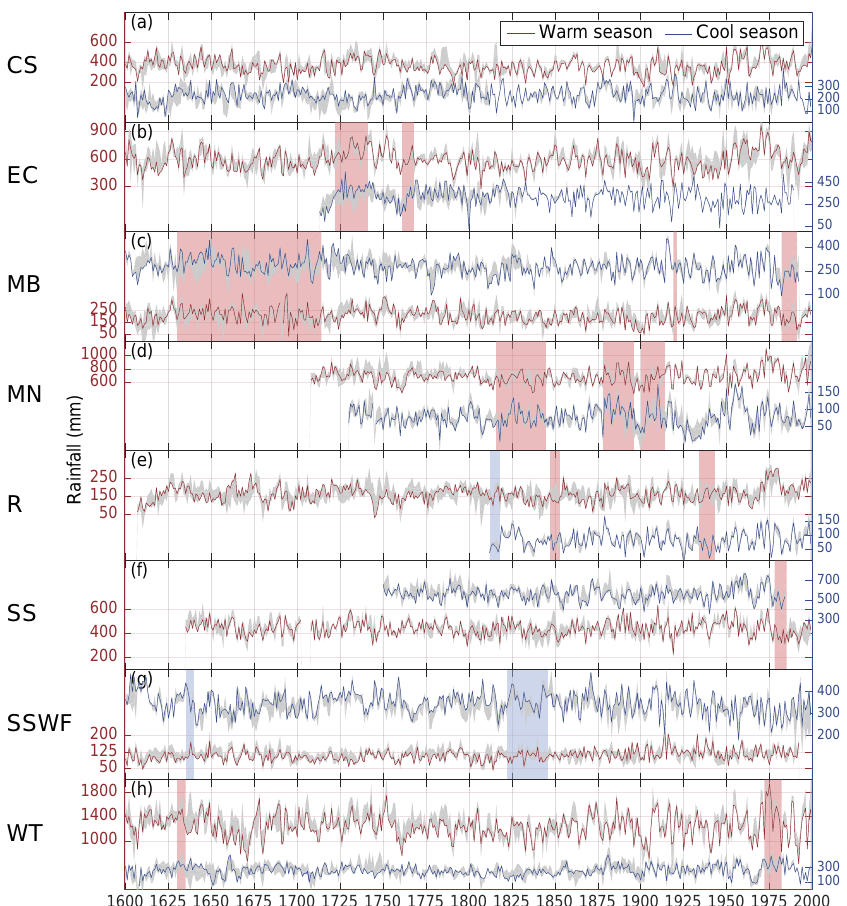
Figure 5. Australian regional rainfall reconstructions in cool and warm seasons. Regional reconstructions for warm- (red line) and cool- season rainfall (blue line) from 1600 to 1984, extended with instrumental data from 1985 to 2015. Note that multiple axes (warm-season rainfall according to left axis, cool season refers to right axis). Shaded in grey are uncertainty estimates based on the ensemble spread. Red and blue shaded periods indicate in-phase and out-of-phase relationships between the seasons based on windowed correlations (30 years) > 0 .